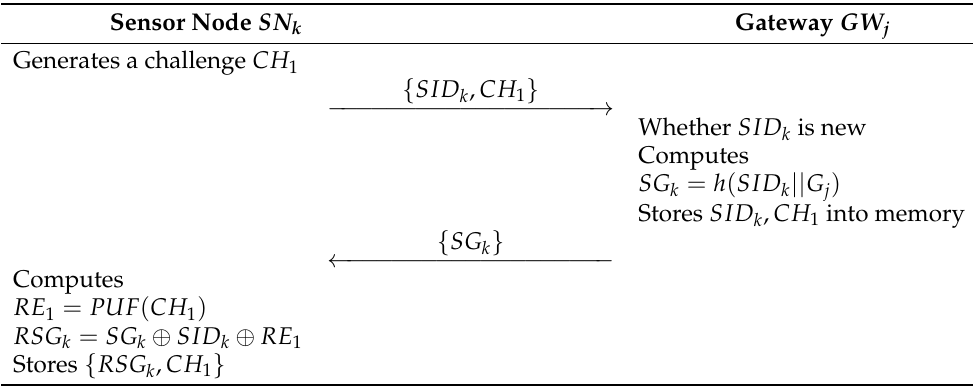
Figure 5. Sensor node registration of the proposed scheme.